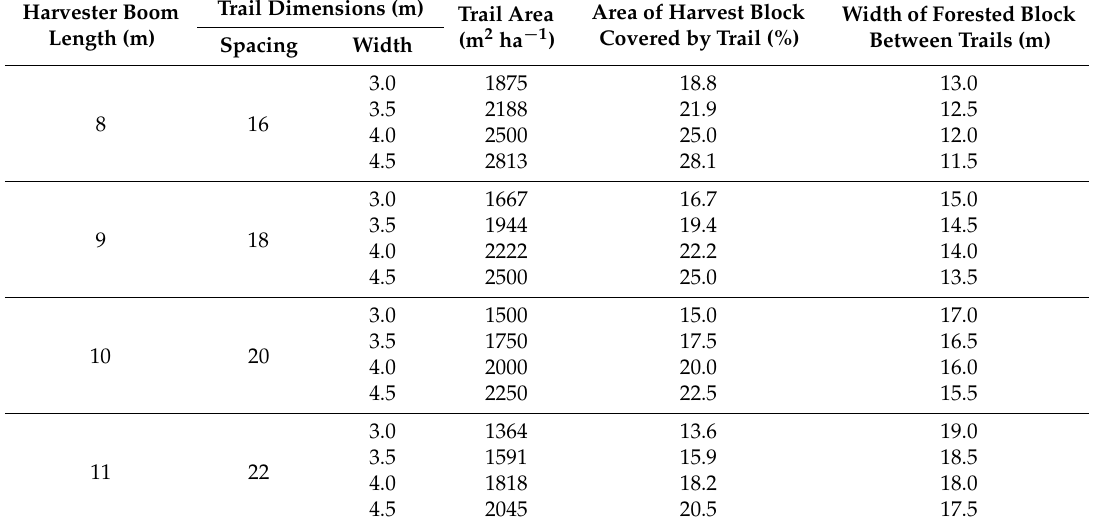
Table 2. Relation between harvester boom length, trail spacing, trail width, and trail area in a fully mechanized cut-to-length